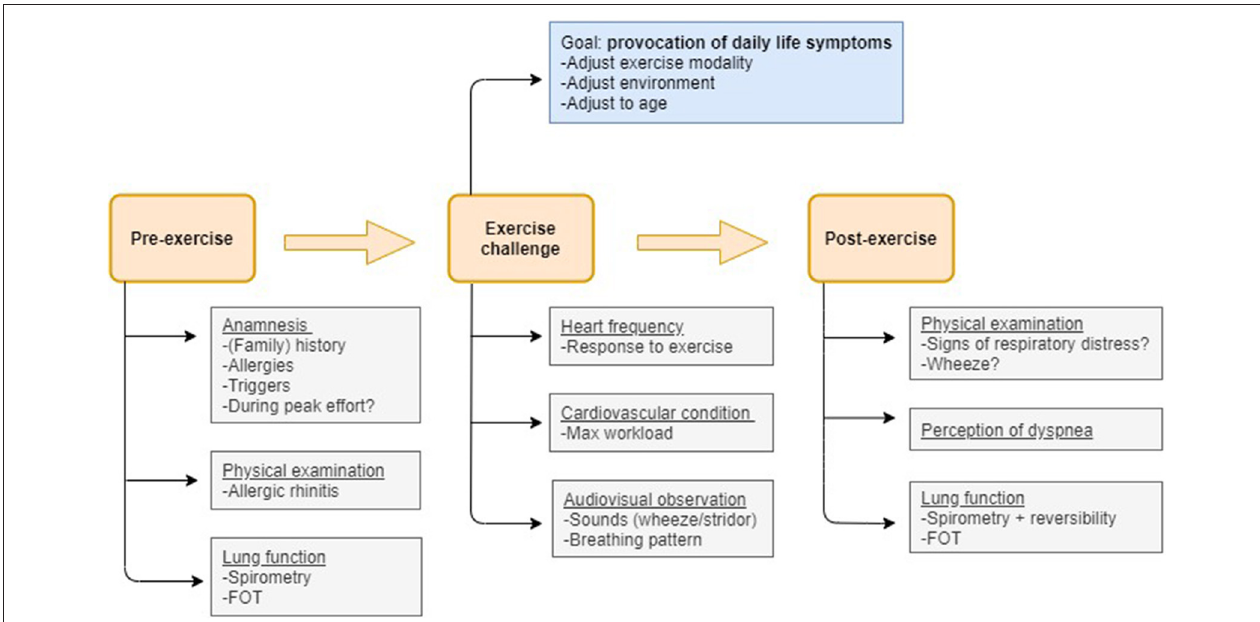
FIGURE 1 | Flow-chart visualizing the measurements and points of attention pre-exercise, during the exercise challenge and post-exercise that allow to disentangle the most prevalent causes of exertional dyspnea in